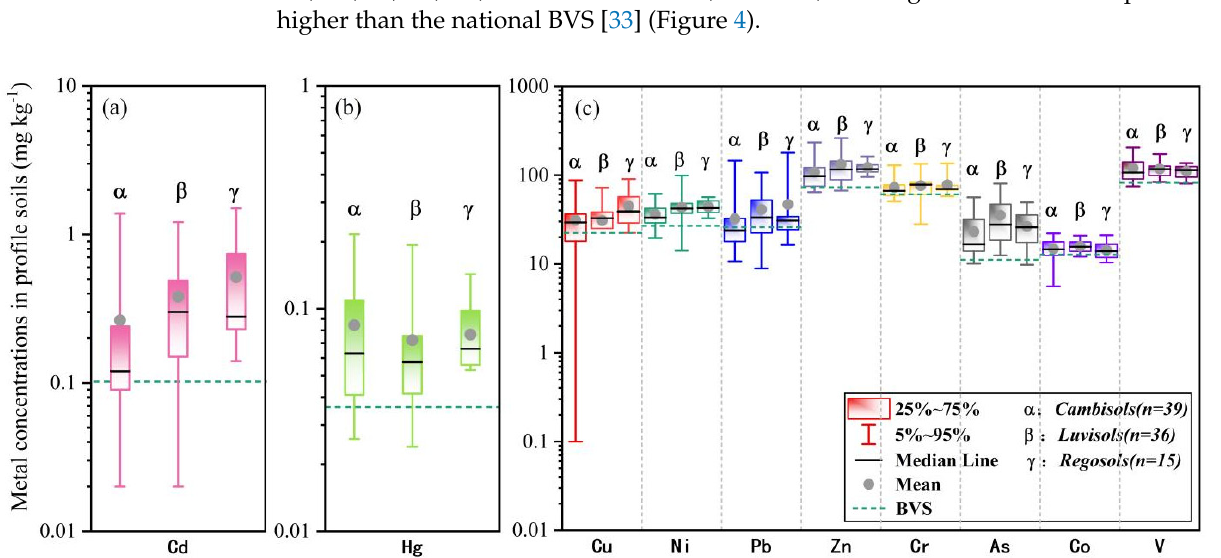
Figure 4. Soil type-dependent distributions of ( a ) Cd; ( b ) Hg; and ( c ) Cu, Ni, Pb, Zn, Cr, As, Co, and V in terra rossa ( n = 90). Bold lines denote the national BVS [33].